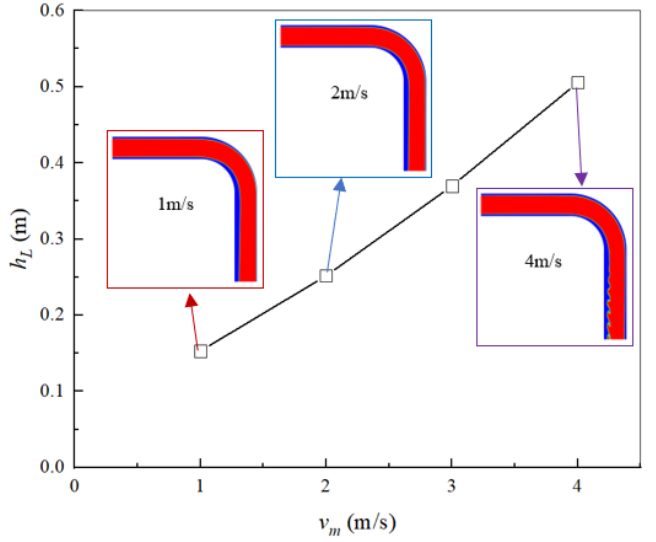
Figure 10. The head loss and the oil–water core–annular flow in the elbow (90° elbow; the same velocity of oil and water).